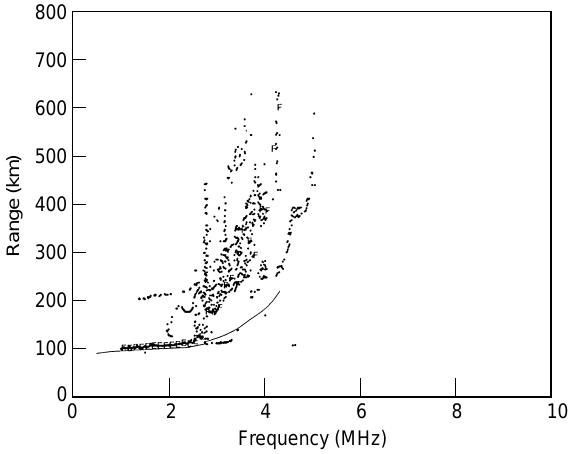
Fig. 8. An ionogram taken at 1210UT on 26 April 1996. The critical frequency was 4 : 3MHz. The solid line represents a fitted true-height electron